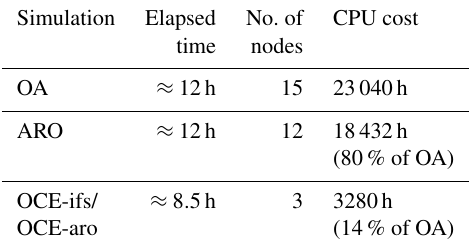
Table A1. Elapsed time and computational cost of the different 7d simulations. One node contains 128 cores, and CPU cost is equal to elapsed time multiplied by the number of nodes multiplied by 128 (the number of cores multiplied by nodes) whatever the true number of nodes effectively